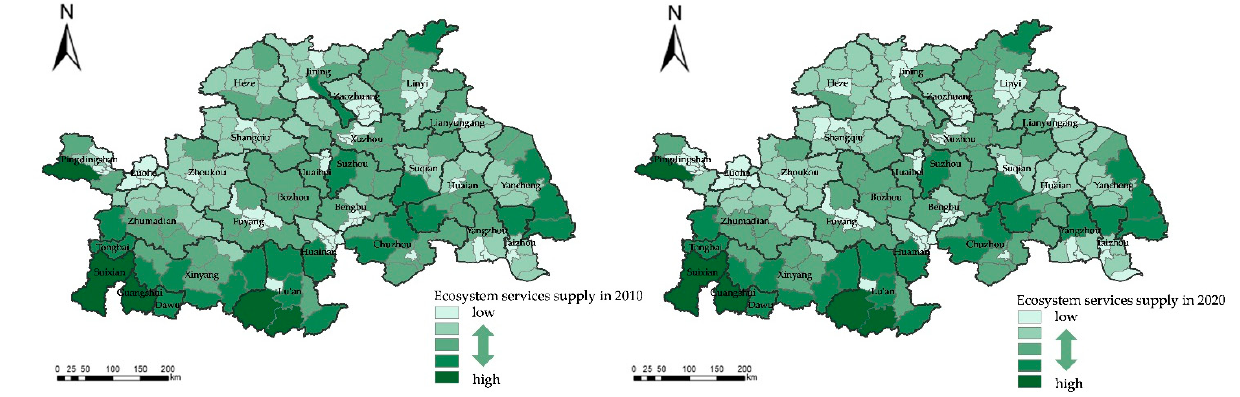
Figure 4. Spatial distribution of ecosystem service supply in the Huai River Basin.